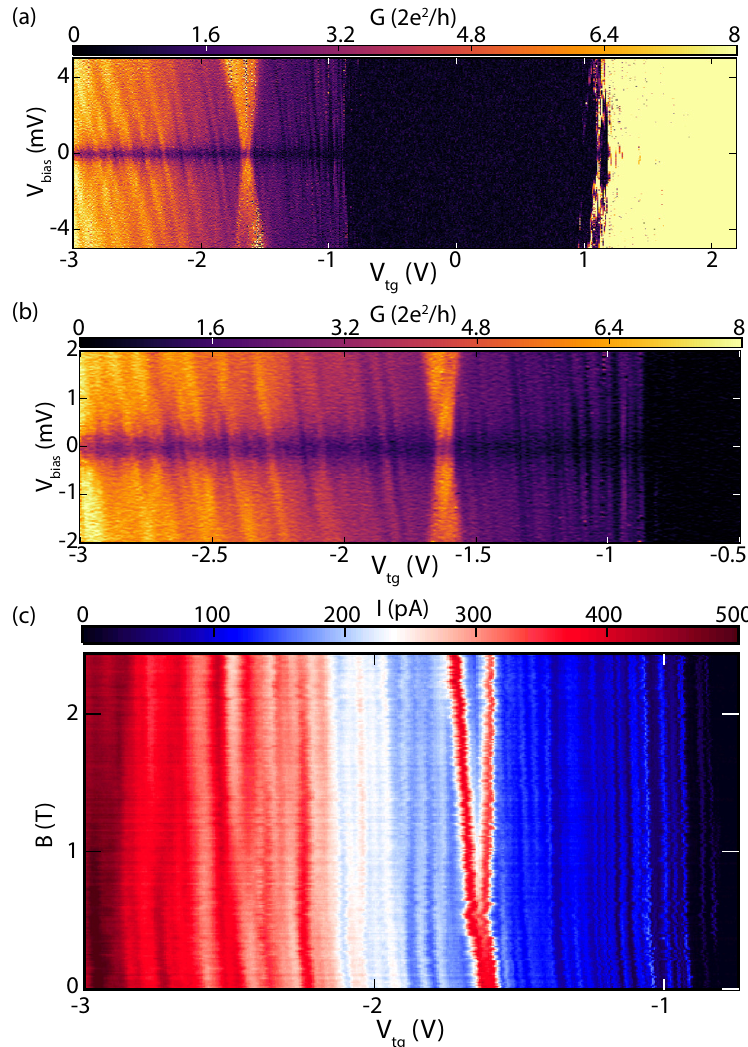
Figure 5: a and b Differential conductance for device 2. c Magnetic field vs topgate on the hole side. Magnetic field is at 45 degrees with respect to the